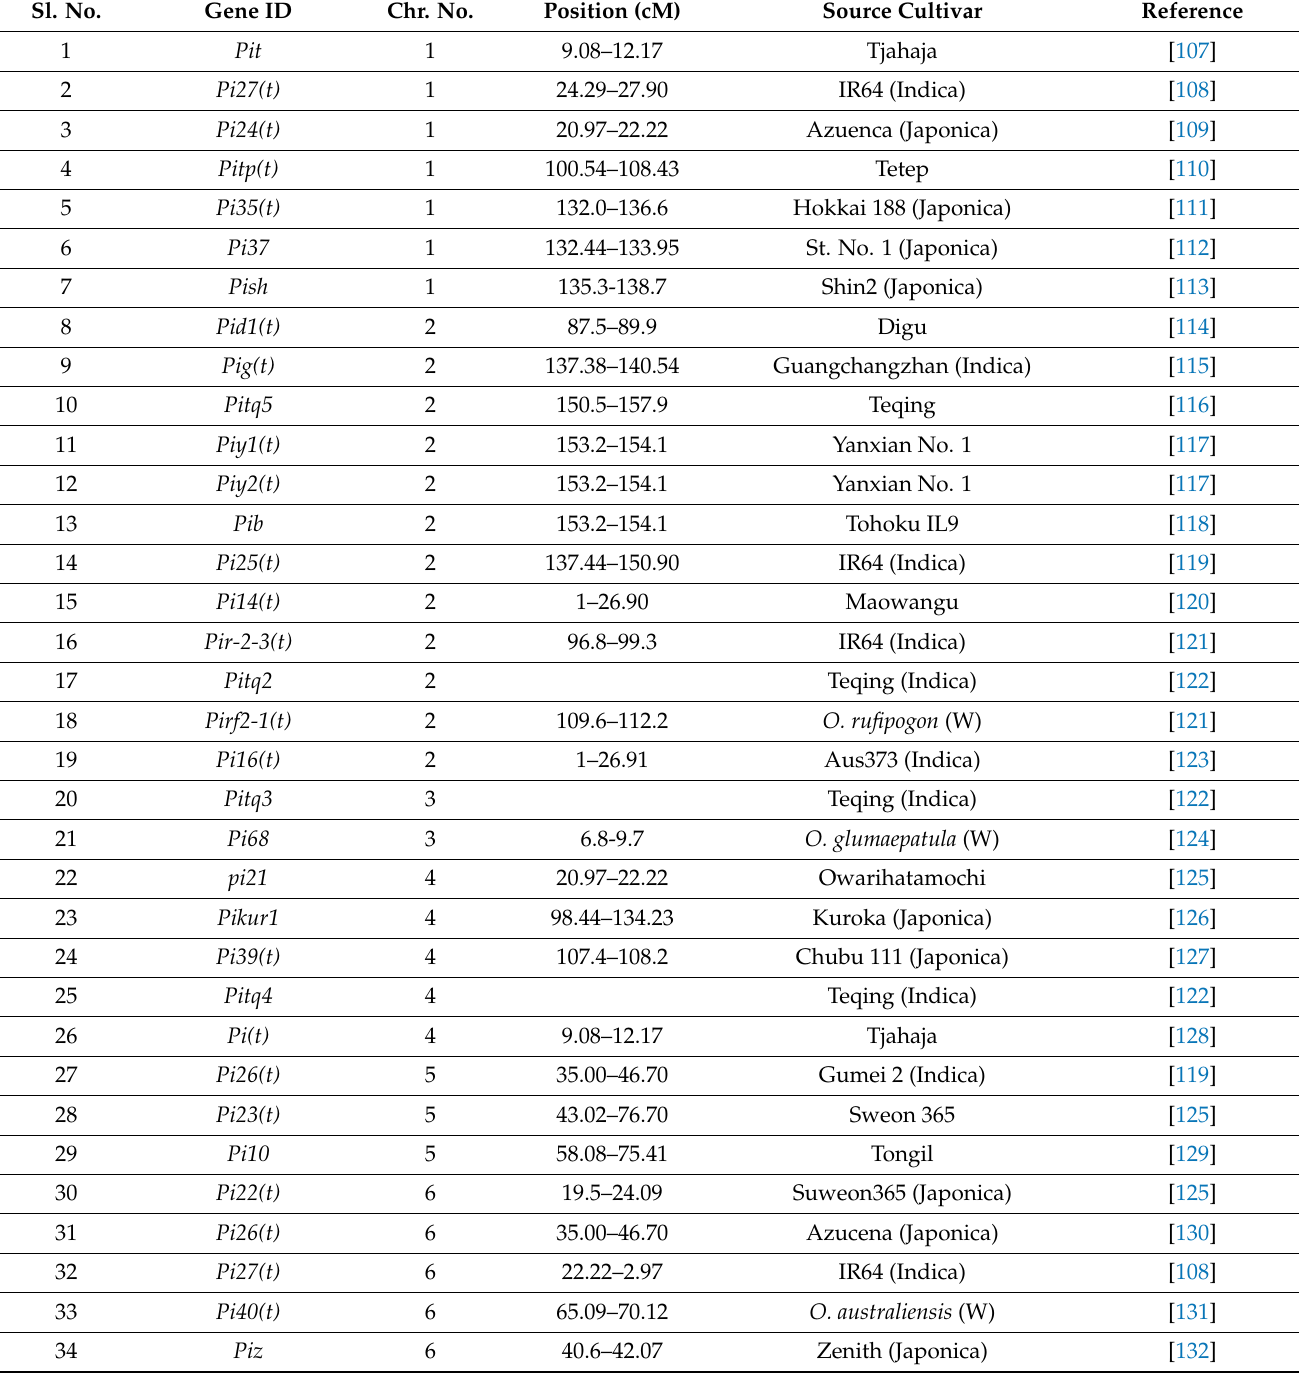
Table 3. Information on mapped rice blast resistance